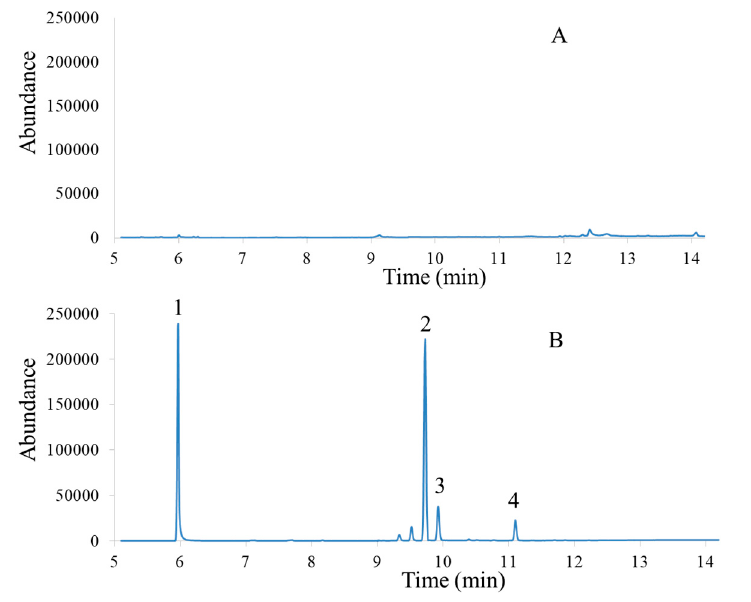
Figure 4. Typical chromatograms of unspiked ( A ) and spiked ( B ) onion extract. Experimental